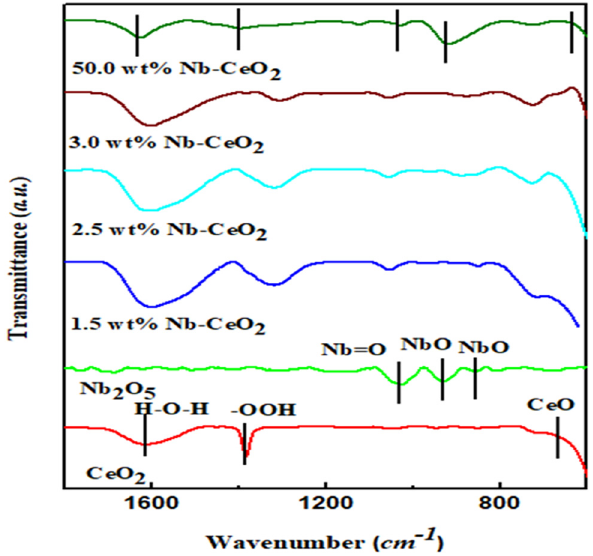
Figure 2: FTIR spectral of the pure and doped samples.